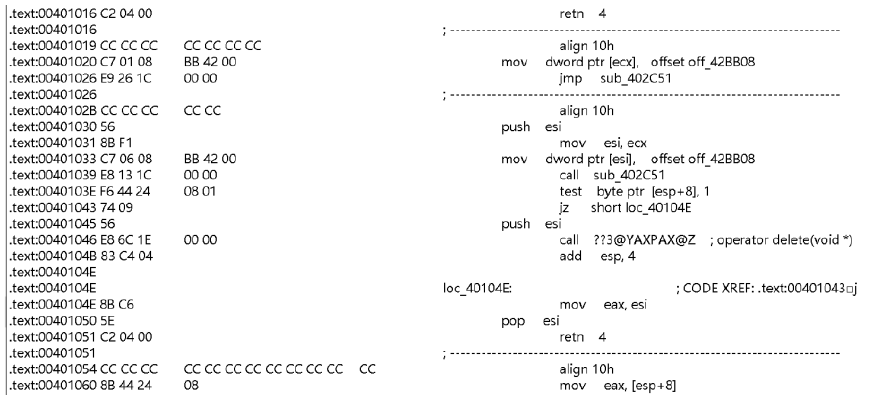
Figure 6. Original opcode sequence.